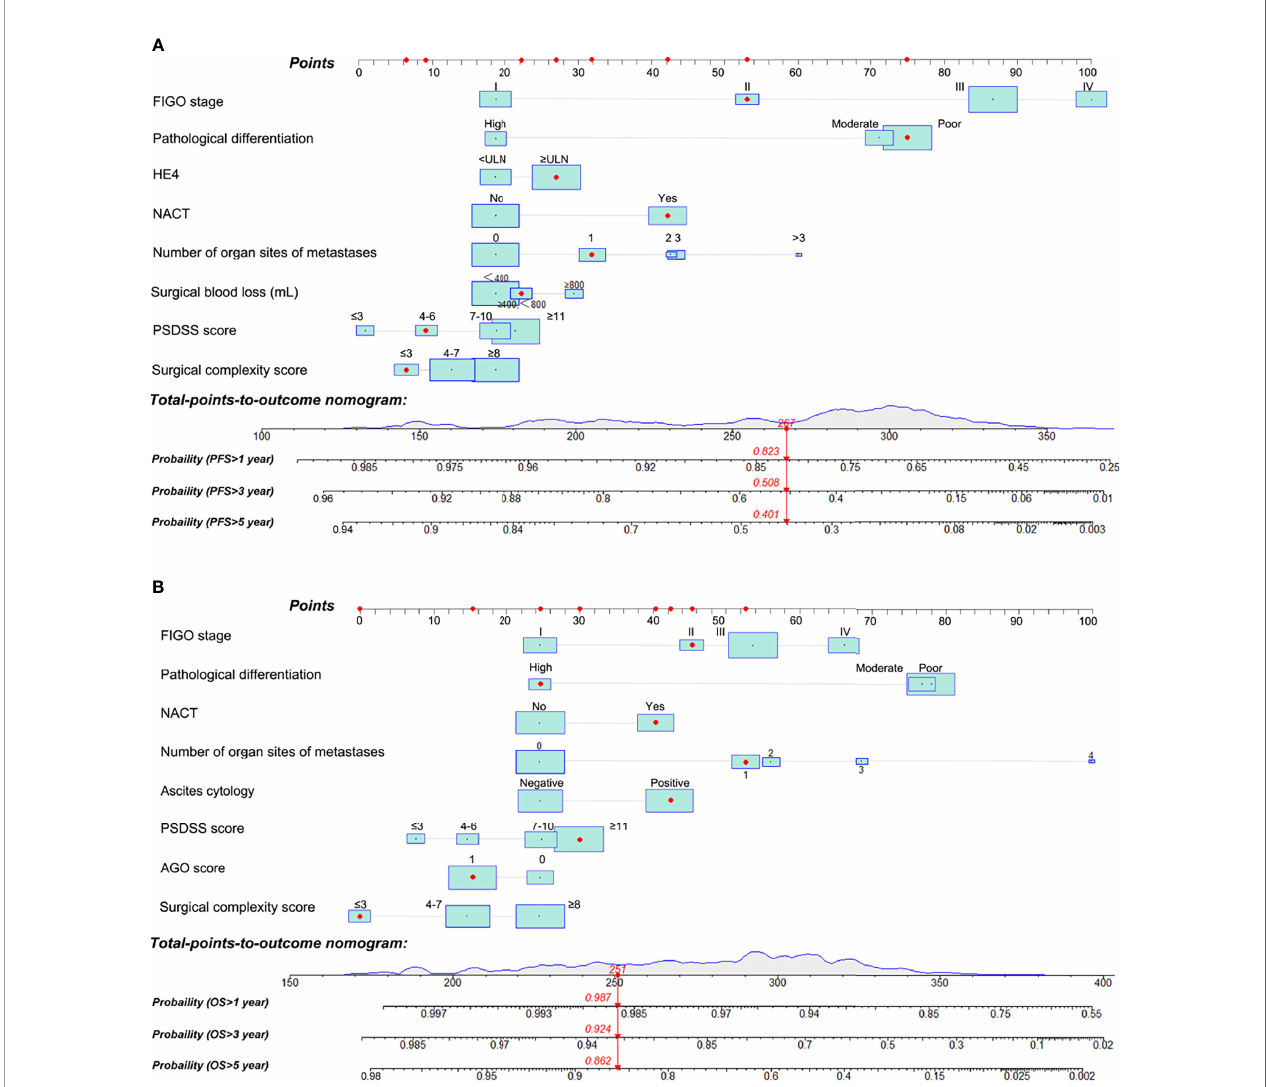
FIGURE 3 | Nomograms for predicting the probability of 1, 3, and 5-year progression-free survival (PFS) (A) and 1, 3, and 5-year overall survival (OS) (B) of patients with epithelial ovarian cancer. PSDSS, peritoneal surface disease severity